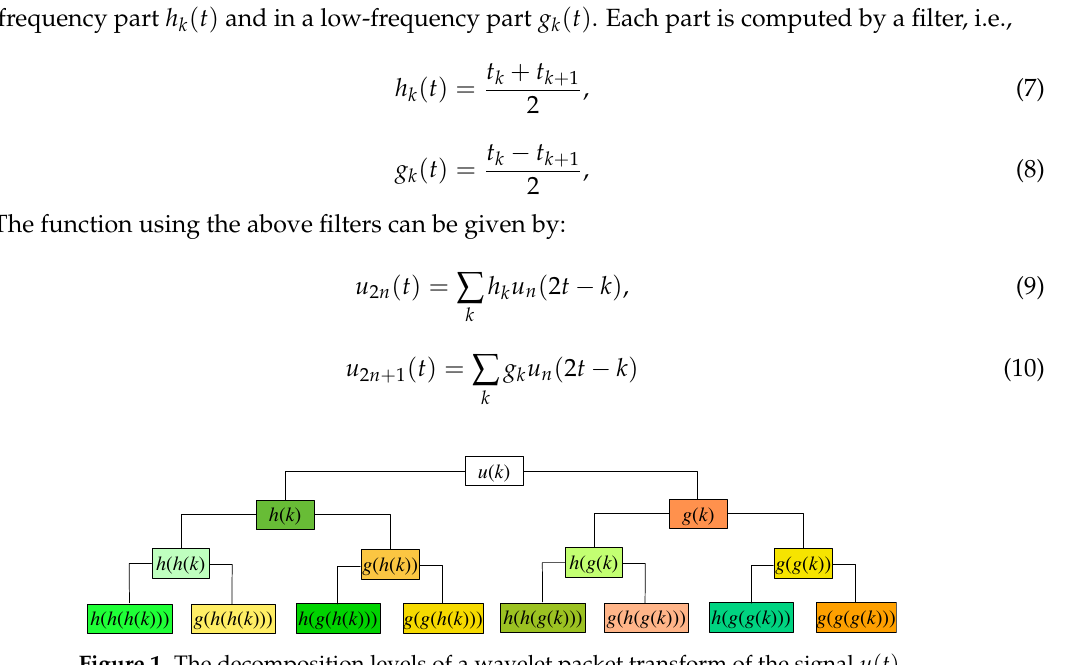
Figure 1. The decomposition levels of a wavelet packet transform of the signal u ( t )